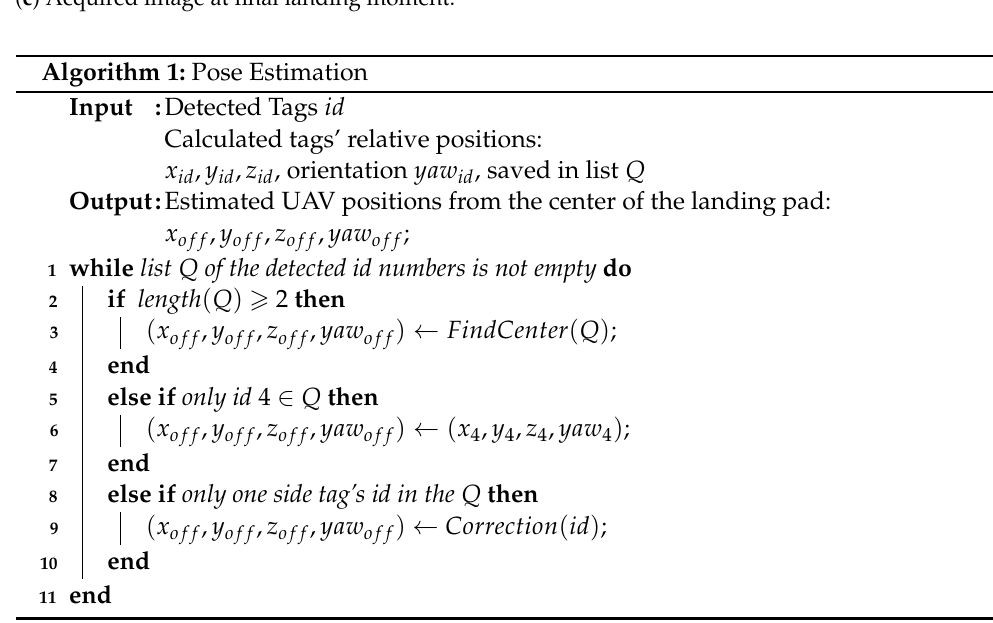
Figure 5. Detection and identification of the AprilTags at different altitudes during the UAV’s auto-landing process: ( a ) Acquired image at high altitude; ( b ) Acquired image at medium altitude; ( c ) Acquired image at final landing